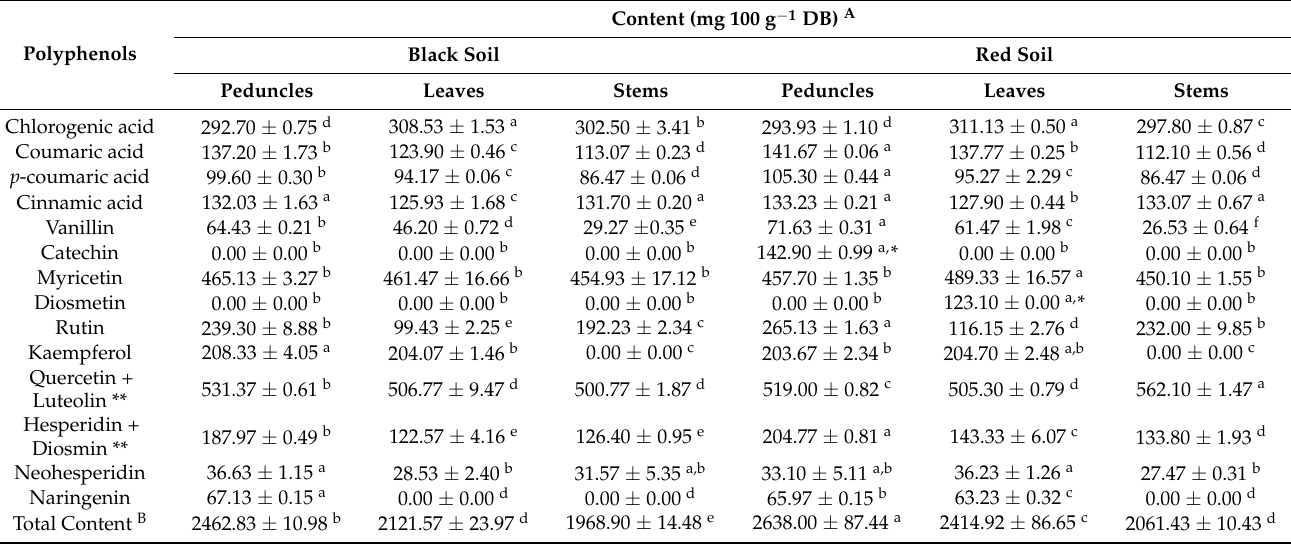
Table 2. Polyphenol content of habanero pepper by-product extracts of plants grown on black or red soils of Yucat á n, M é xico obtained by